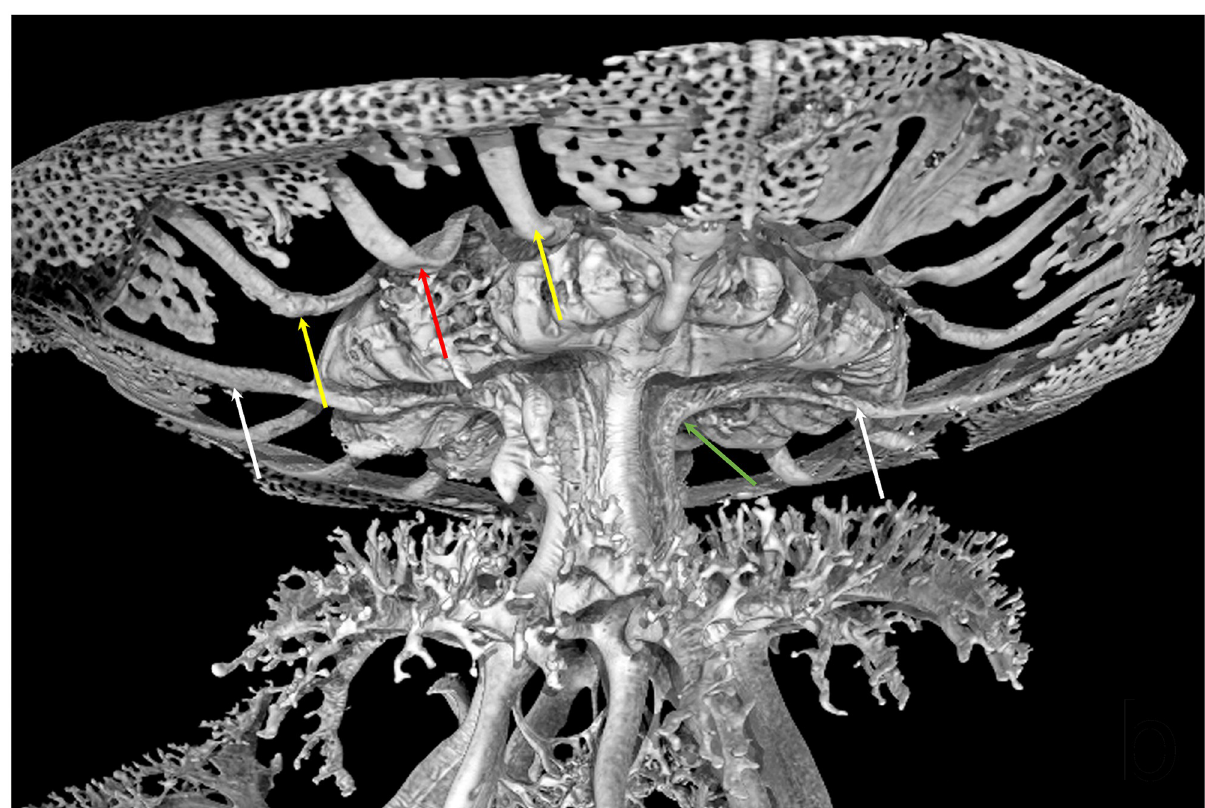
Fig 2. Volume rendering of the resin endocast obtained via X-ray μ CT, showing an enlarged view of Fig 1b: Detail of the stomach, subumbrellar view. The radial canals per quadrant, emerging from the stomach are visible. Arrows indicate: two perradial canals (white), one interradial canal (red), two adradial canals (yellow) and the perradial canal passage into the manubrium (green). CT reconstruction performed with an isotropic voxel size of 62.0 μ m.